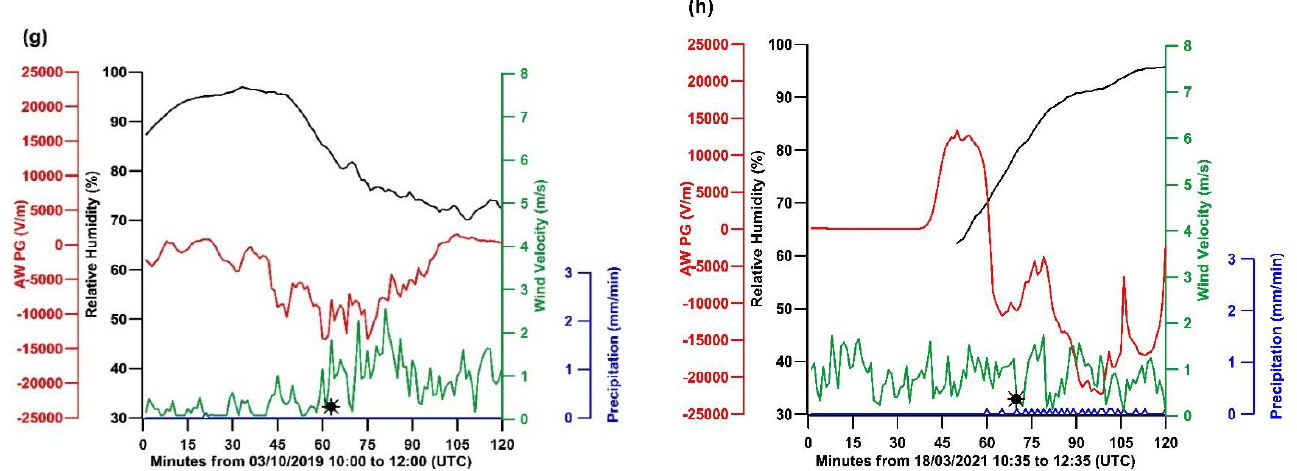
Figure 3. Same data as in Figure 2, but with 1-minute resolution. ( a ) Hail event 22/05/2012; ( b ) Hail event 22/03/2013; ( c ) Hail event 11/04/2014; ( d ) Hail event 02/07/2016; ( e ) Hail event 14/06/2018; ( f ) Hail event 03/08/2019; ( g ) Hail event 03/10/2019; ( h ) Hail event 18/03/2021. The asterisk denotes the start of hail.